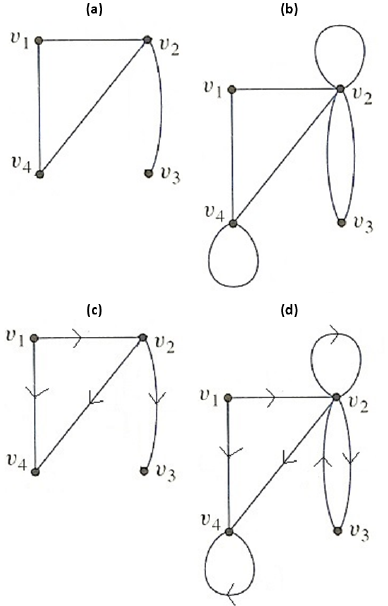
Figure 1: (a) Undirected and without self-cycles/loops and multiple edges. (b) Undirected and with self-cylcles/loops and multiple edges. (c) Di- rected and without self-cycles/loops and mul- tiple edges. (d) A directed and with self-cy- cles/loops and multiple